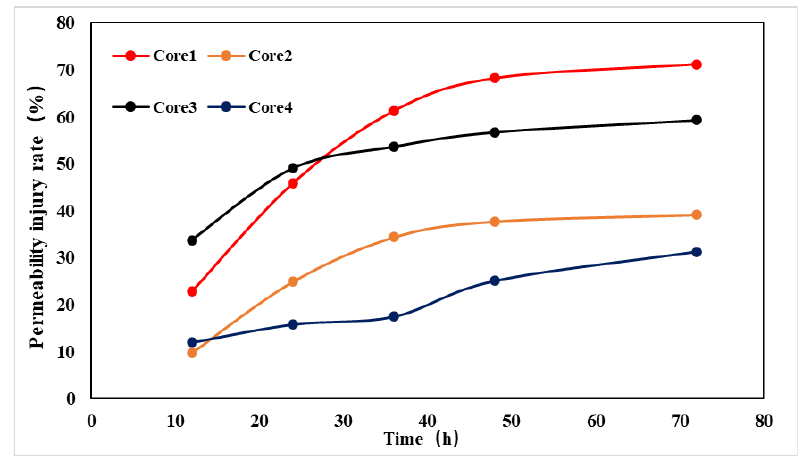
Figure 9. Overall damage rates of different rock samples under different action times of foaming agent solutions.